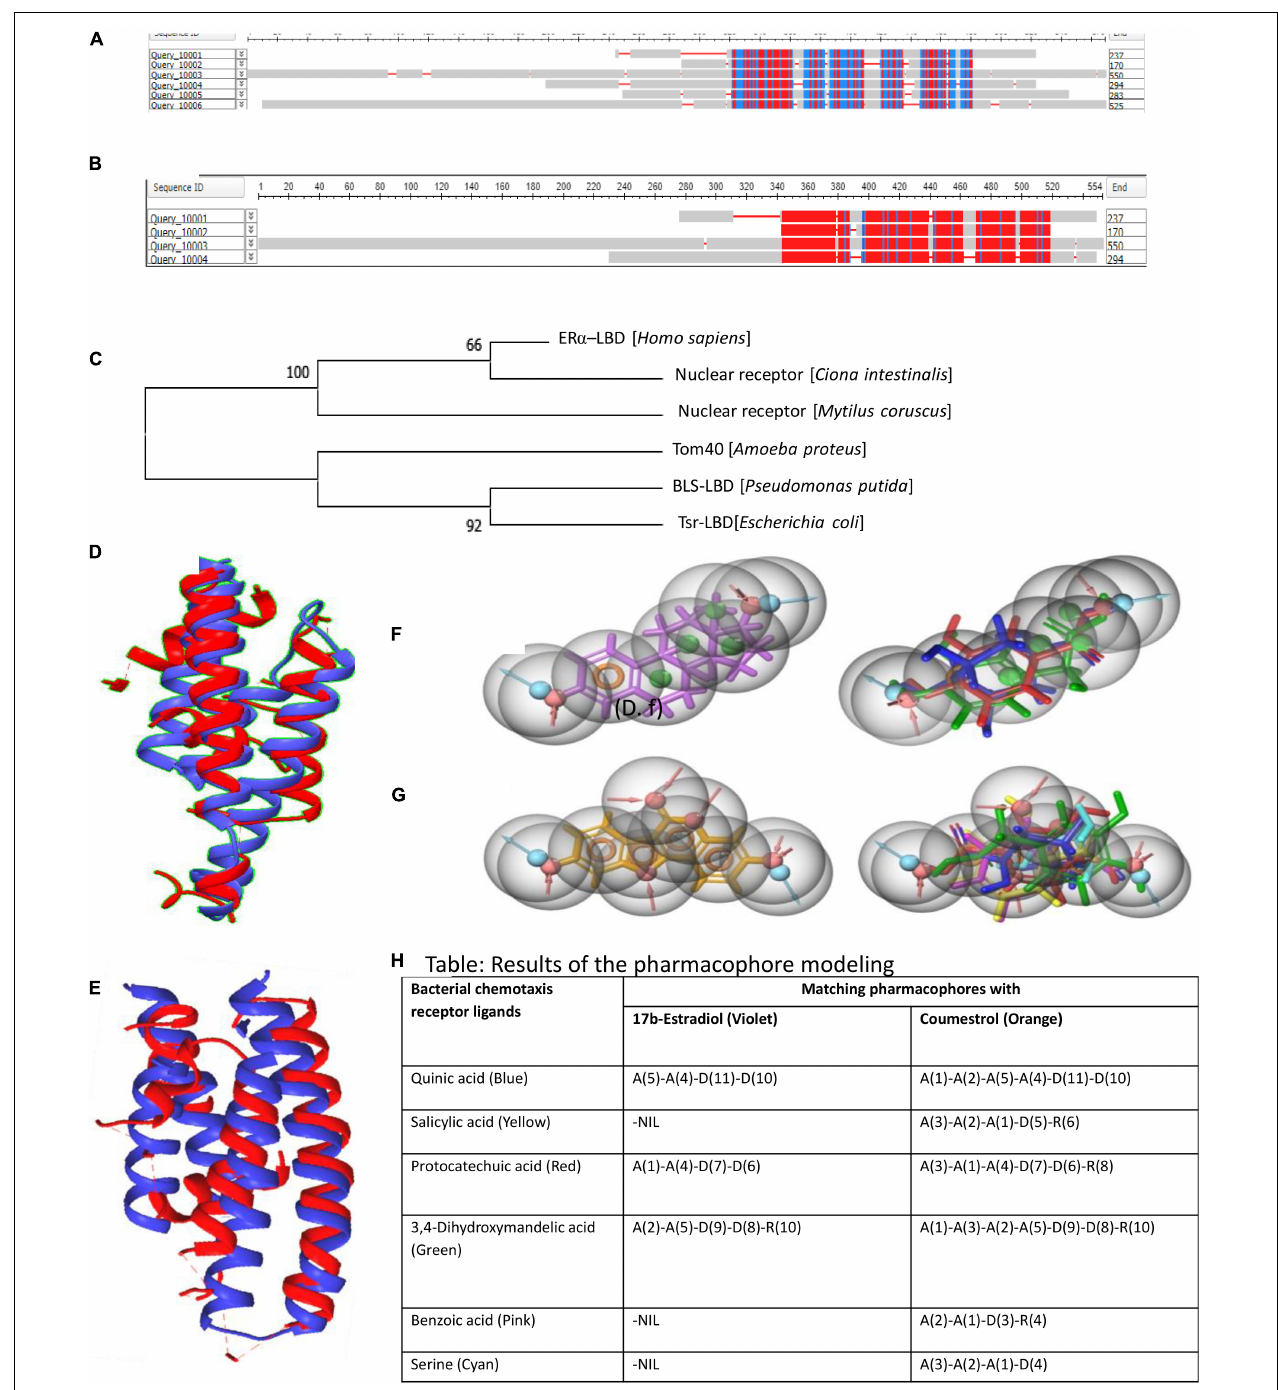
FIGURE 1 | Constraint-Based Multiple Alignment Tool results for the selected sequences. (A) Six sequences. (B) Selected four sequences. Here, the highly conserved and least conserved regions are highlighted based on residues relative entropy threshold. Alignment columns with no gaps are colored in red or blue. Red indicates highly conserved regions, and blue indicates less conserved regions. (C) The gene tree constructed with MEGA version X is represented. (D,E) TM-align results: (D) structural alignment of human ER- α -LBD superposed on Tsr-LBD ( E. coli ); (E) structural alignment of human ER- α -LBD superposed on broad ligand chemoreceptor, LBD ( P. putida ). Blue chain represents bacterial taxis receptors, and red chain represents human ER-alpha. Superposed full-atom structure of the aligned region is represented as cartoon. (F,G) Pictorial representation of pharmacophore modeling results. (F) The pharmacophore of the reference ligand 17 β -estradiol (left, violet) and the result of the ligand database screening (right) for the identification of matching pharmacophores. (G) The pharmacophore of the reference ligand coumestrol (left, orange) and the result of the ligand database screening (right) for the identification of matching pharmacophores. Detailed color codes are given in tabular form (H) . (H) Tabular representation of pharmacophore modeling results.